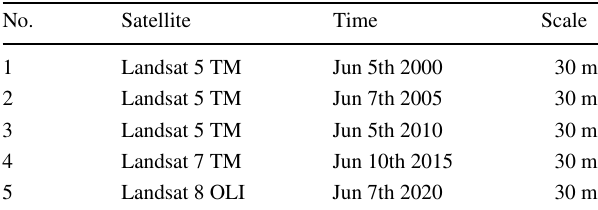
Table 1 Remote sensing parameters No. Satellite